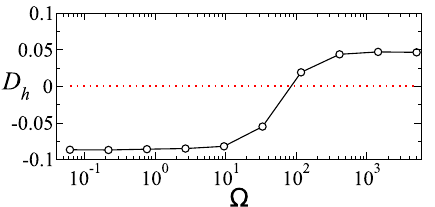
Fig. 7 Wetting transition with forcing frequency. Variation of D h versus Ω for ε = 10, σ = 6, and O c = 0.01. The droplet undergoes